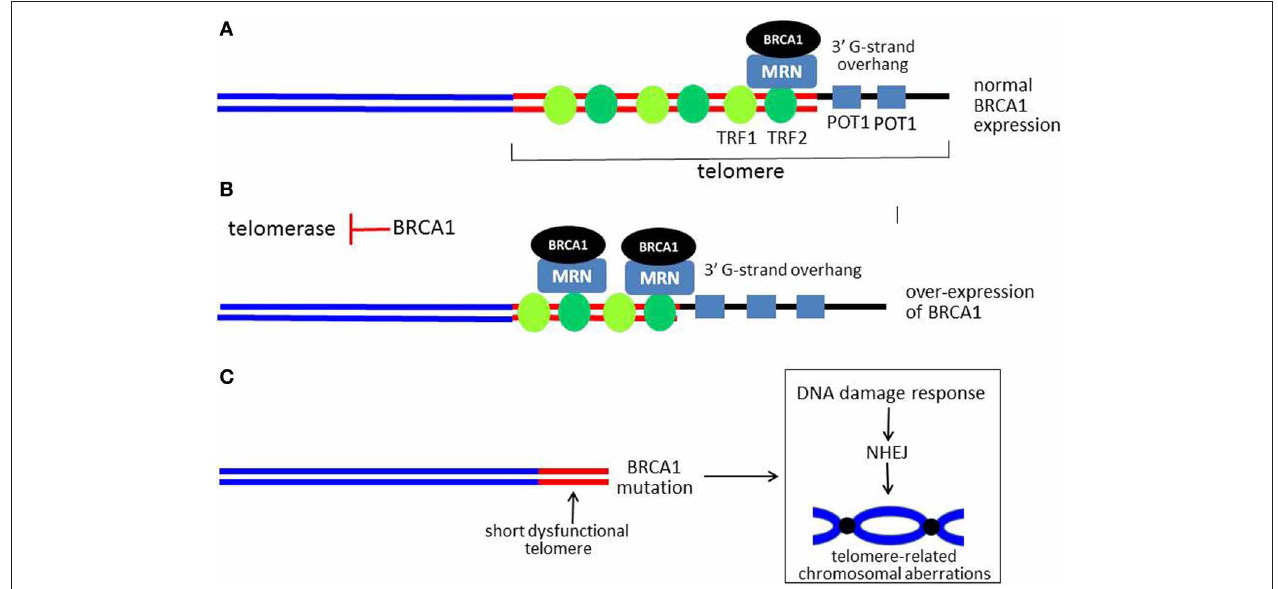
FIGURE 5 | Model for role of BRCA1 in telomere maintenance. (A) Shows a linear representation of a normal functional telomere. For simplicity, not all of the telomere-associated proteins are shown. BRCA1 is recruited to the telomere by RAD50, a component of the MRN complex, which is also present at the telomere. When BRCA1 is over-expressed, more BRCA1 is present at the telomere. BRCA1 causes overall telomere shortening, but the 3 (cid:2) G-strand overhang is lengthened, as illustrated in